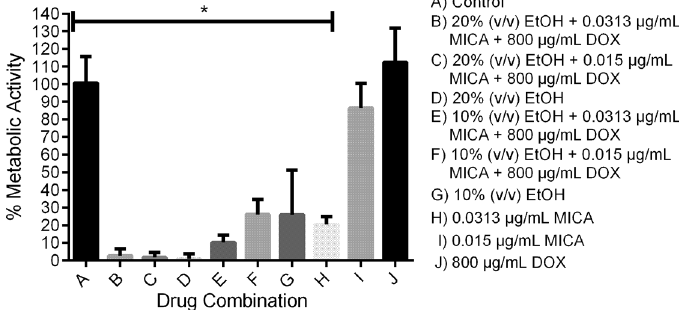
Fig 2. Treatment of mature SC5314 biofilms on silicone disks. Potential lock solutions significantly reduced metabolic activity of mature C . albicans biofilms. Biofilms were incubated on silicone for 24 hour at 37°C with potential lock solutions. Metabolic activity was measured using XTT reduction. Untreated and drug treated groups were compared using two-way ANOVA followed by Tukey post analysis. * indicates p value of < 0 .